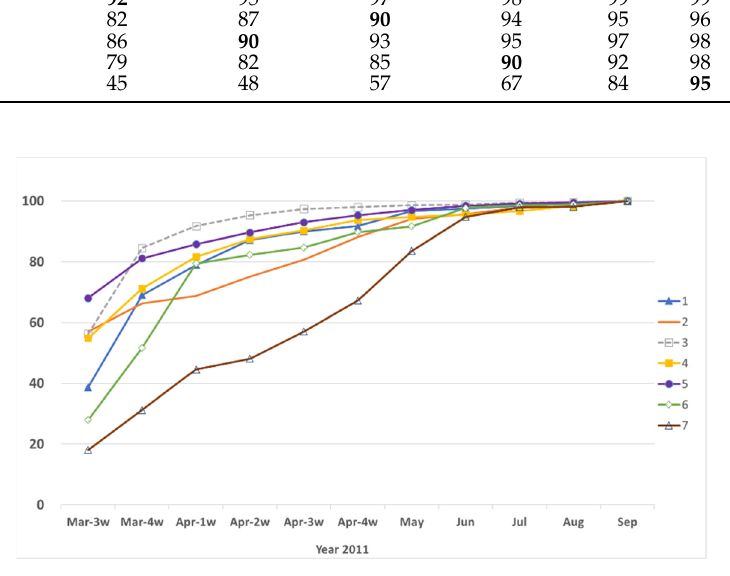
Figure 4. Road recovery conditions of the seven clusters in Fukushima Prefecture.